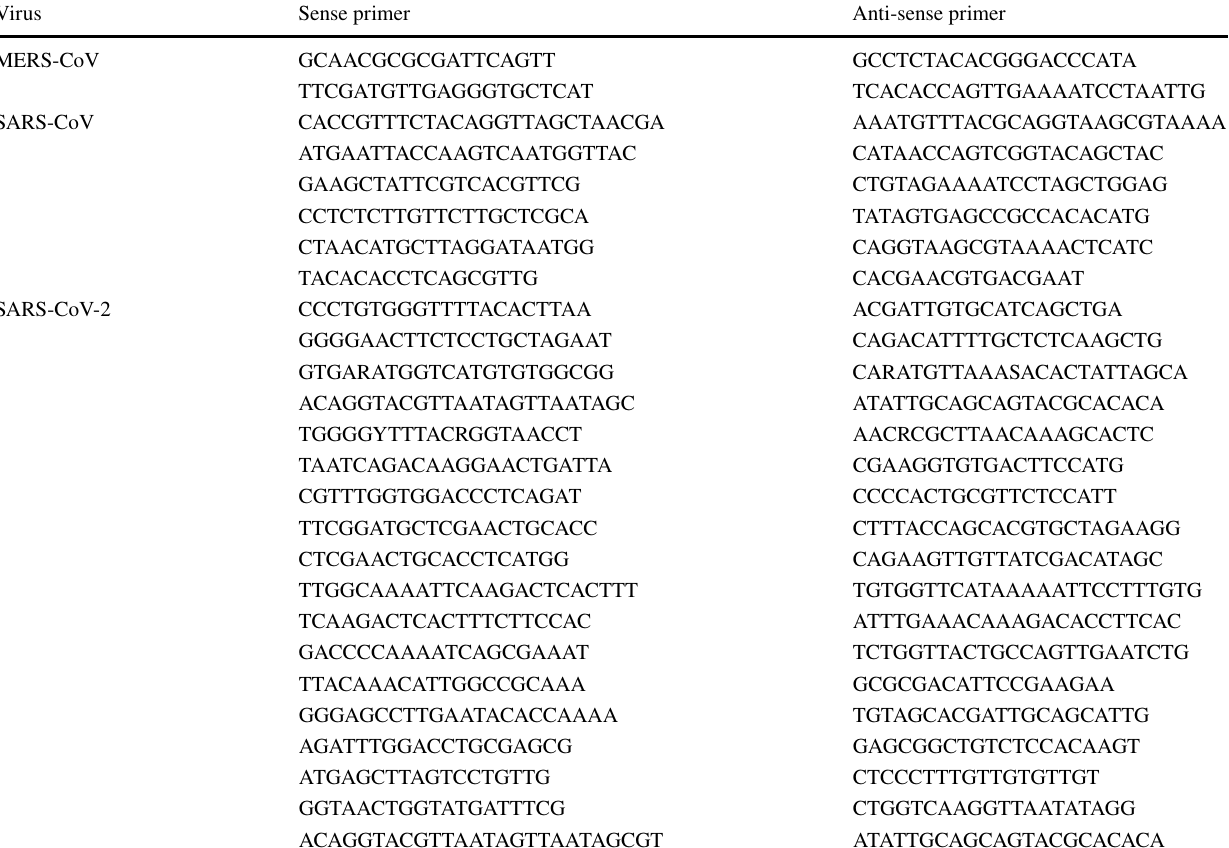
Table 1 Universal primer pairs introduced for the amplification of high pathogenic coronaviruses‑related genes [55] Virus Sense primer Anti‑sense primer